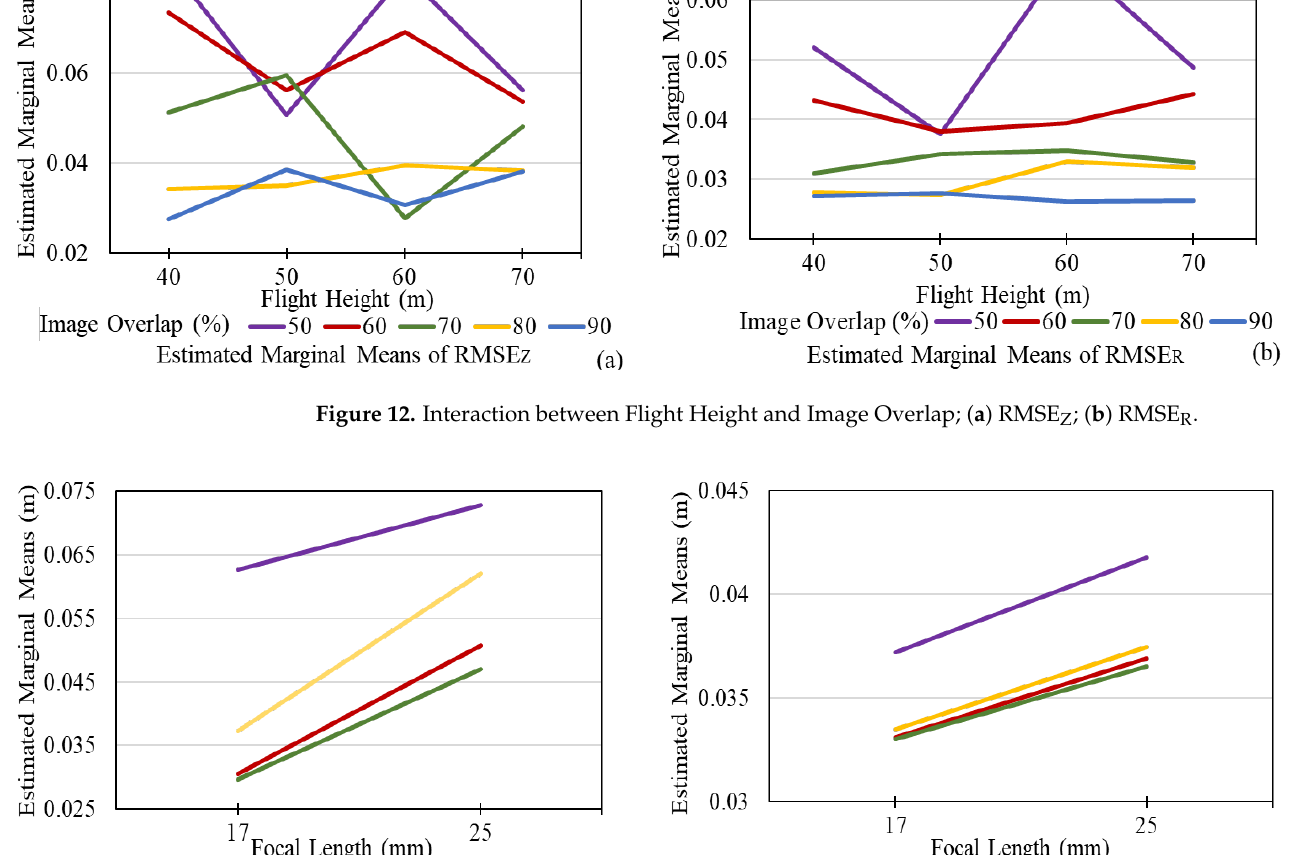
Figure 13. Interaction between Focal Length and GCP Quantity; ( a ) RMSE Z ; ( b ) RMSE R.